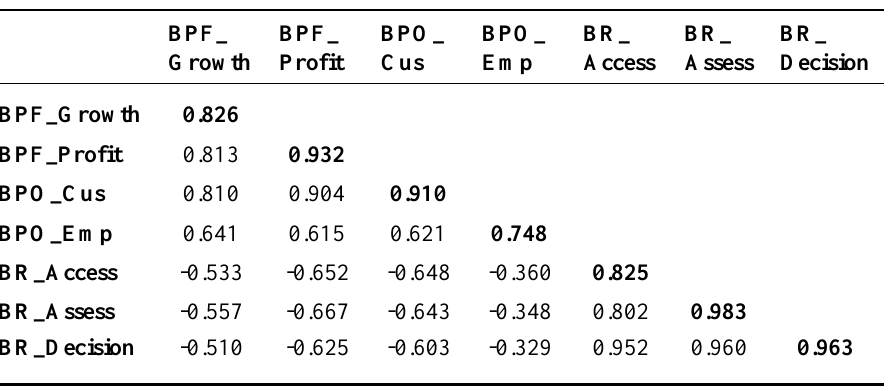
Table 02: Discriminant Validity of First Order